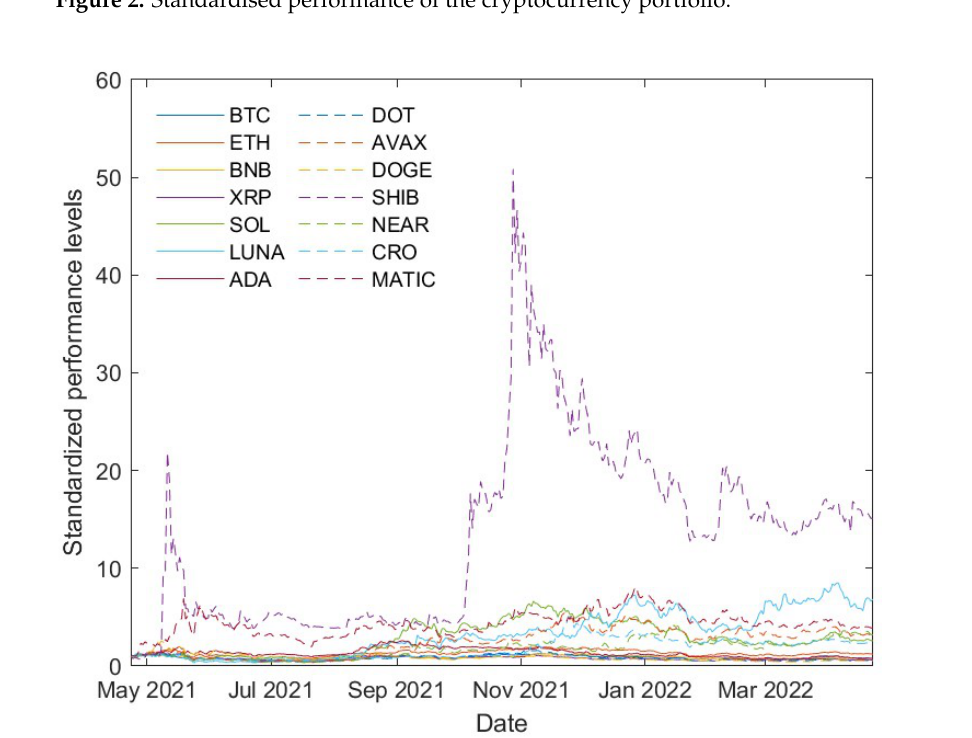
Figure 3. Standardised performance of the individual portfolio